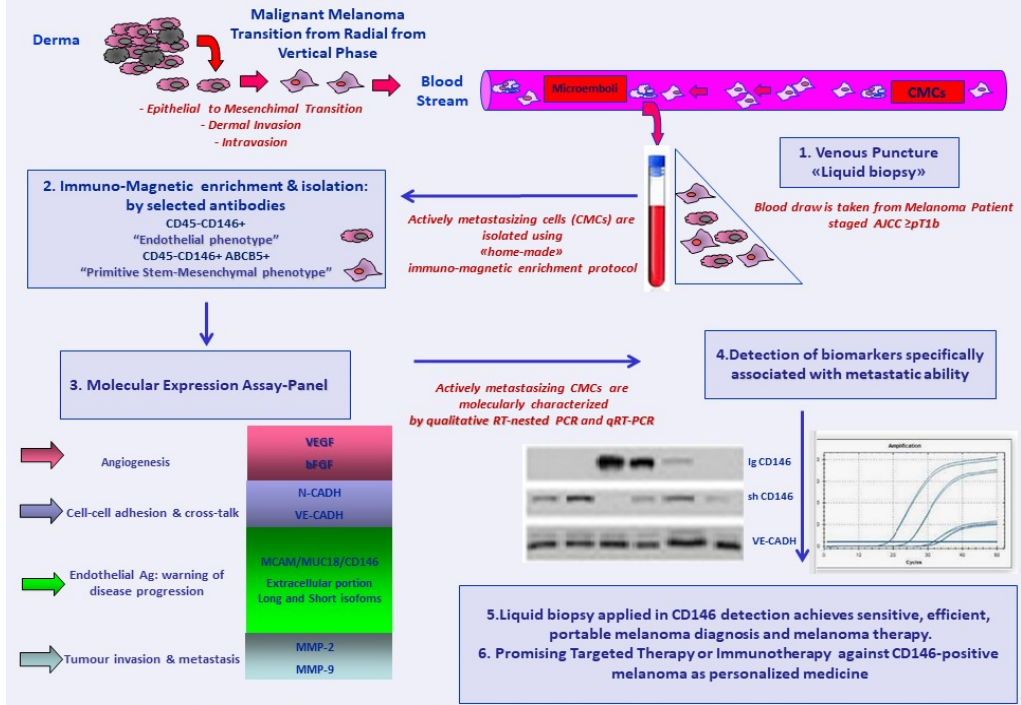
Figure 4. Schematic diagram of our current method for detection, isolation and enrichments of actively metastasizing CMCs.